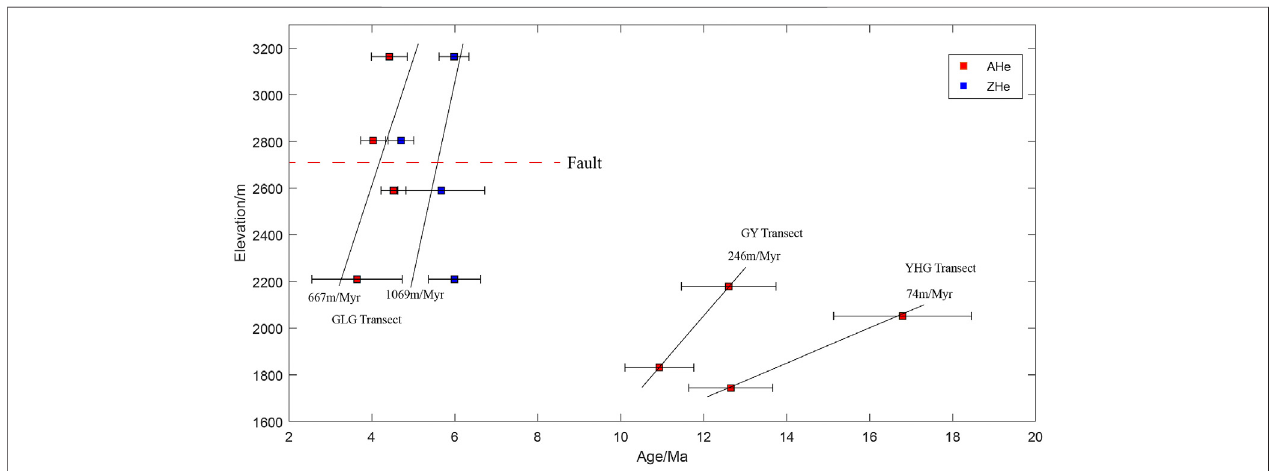
FIGURE 4 | Age – elevation relationship diagram of low-temperature thermochronological data of Ahe and Zhe.